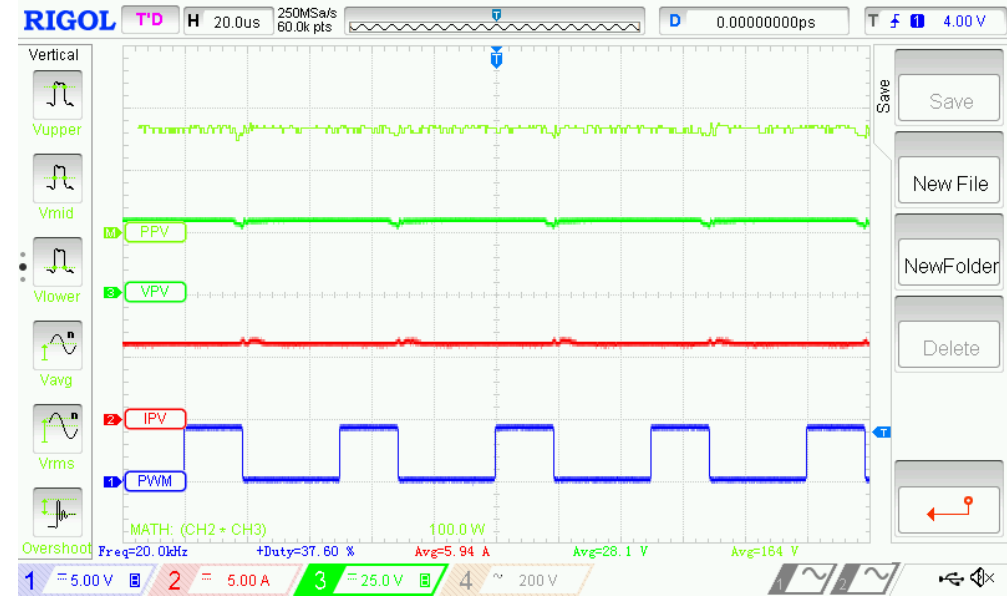
Figure 17. Waveforms of the PV system.